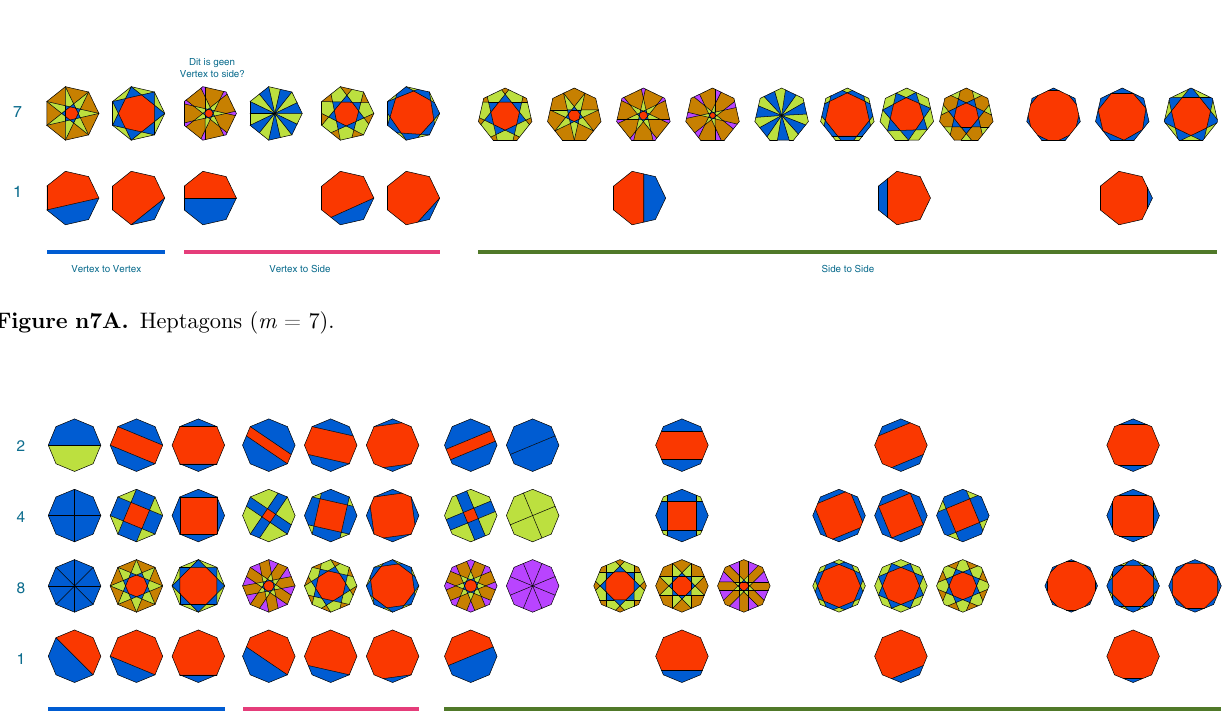
Figure n6A. Hexagons ( m = 6).